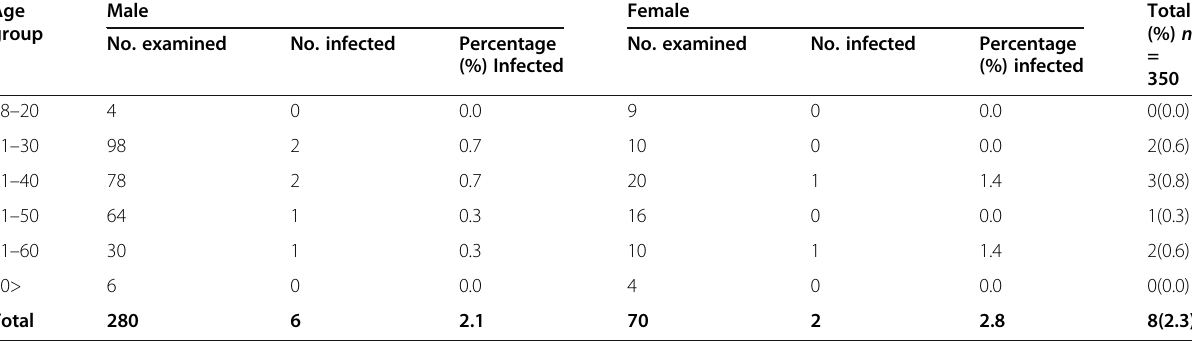
Table 3 Prevalence of T. vaginalis and HIV co-infection among inmates in relation to age and gender in Umuahia Prison, Abia State Age Male Female Total group 350No. examined